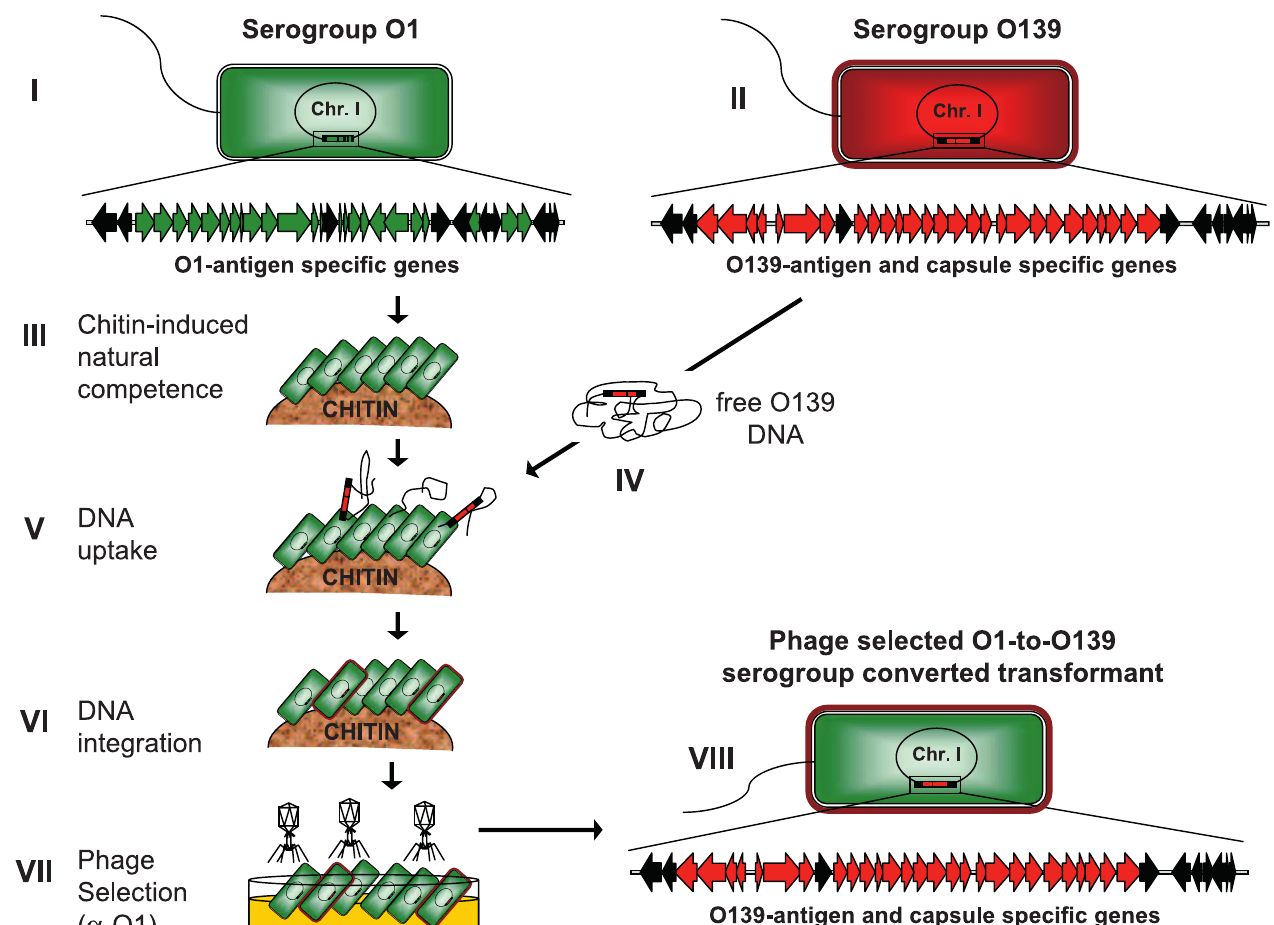
Figure 4. Schematic Representation of V. cholerae Serogroup Conversion by Chitin-Induced Transformation and Phage-Mediated Selection V. cholerae serogroups O1 (I) and O139 (II) are shown as green and red bacteria, respectively. They differ in the size and composition of the O-antigen moiety of LPS and by the presence of a polysaccharide capsule on the surface of the O139 serogroup. These differences are encoded by the O-antigen– specific gene cluster depicted below each bacterium. Black arrows (I, II, and VIII) denote the location of homologous genes present in both serogroups (for detail, see Figure 1). V. cholerae O1, grown on a chitin surface, becomes competent for transformation (III). Free DNA from the O139 donor strain (IV) is taken up (V) and integrated into the chromosome by homologous recombination (VI). Exchange of the O1 gene cluster for the O139 cluster leads to serogroup conversion. The transformed recipient produces the O139 O antigen and CPS (VIII) and becomes resistant to O1-specific bacteriophages